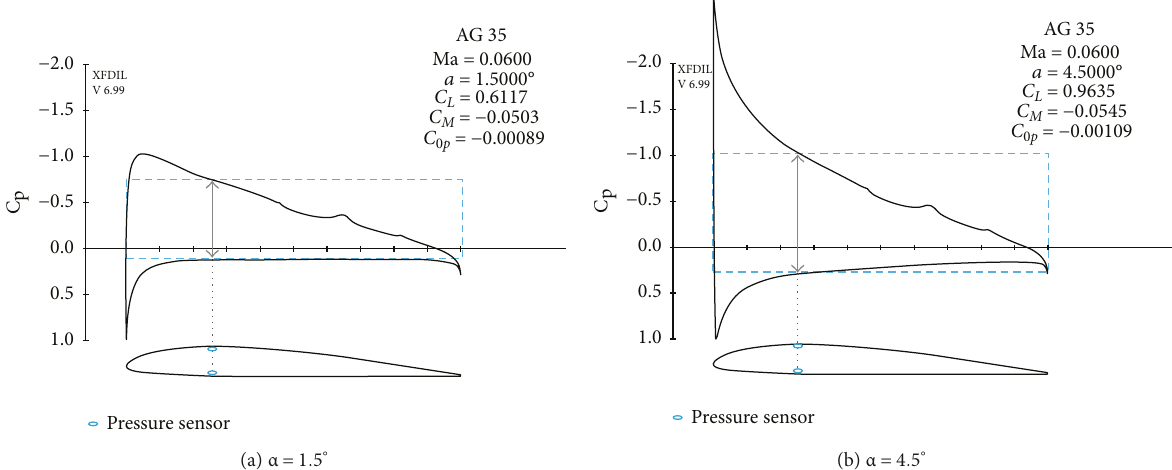
Figure 2: Di ff erences in pressure on the upper and lower main wing surfaces, with blue circles representing pressure